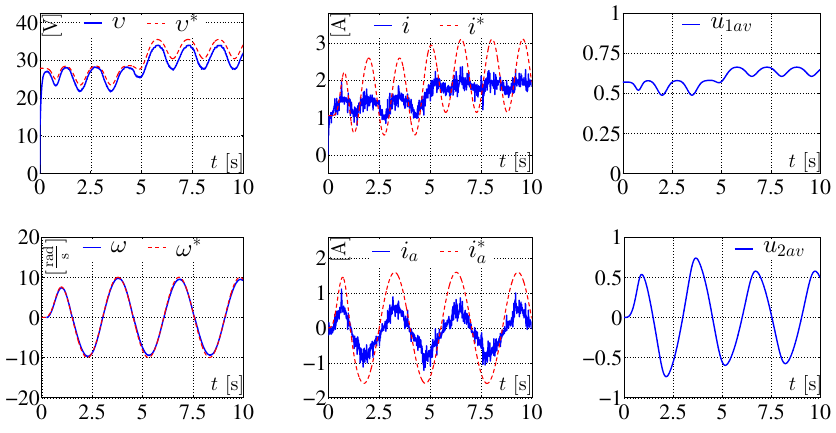
Figure 12. System response for Equations (32) and (40).